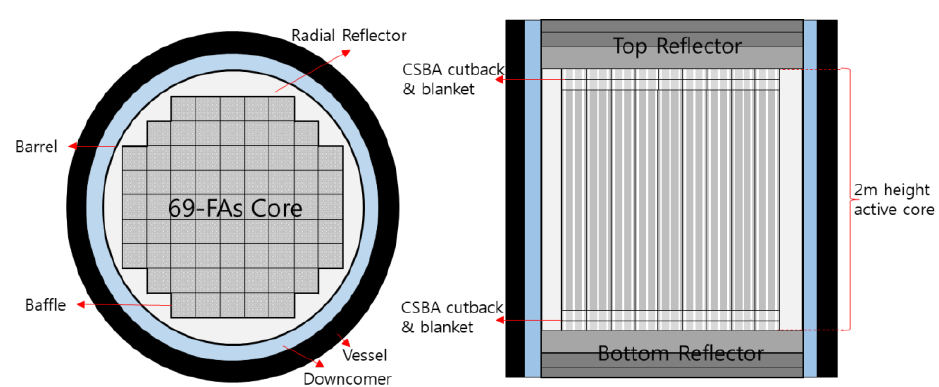
Figure 2: Radial and Axial Layouts of the ATOM Core